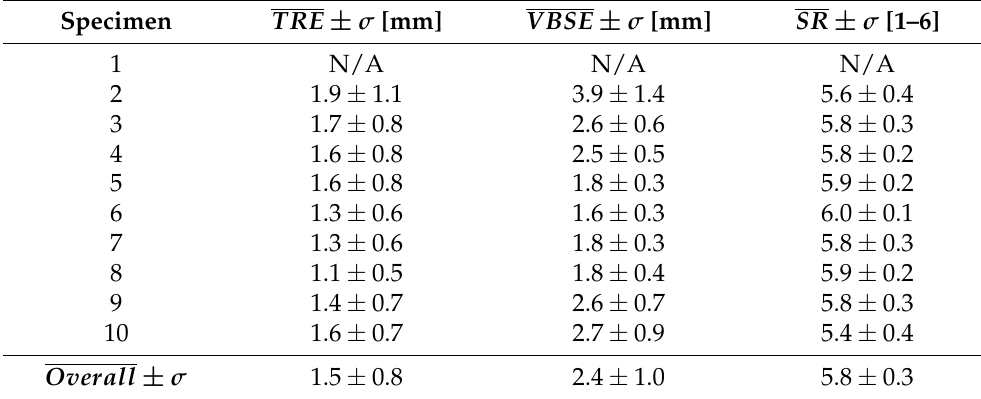
Table 3. Overview of the mean outcome measures target registration error (TRE), visible bone surface error (VBSE) and surgeon’s rating (SR) for each